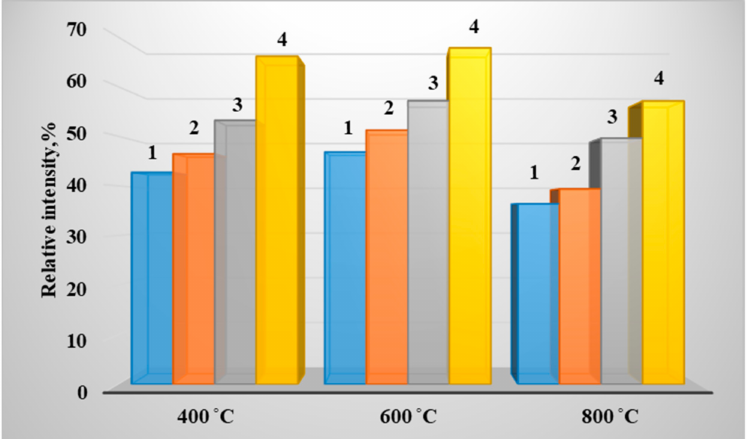
Figure 7. The results of the analysis of the content of aluminum sulfate in ash of brown coal grade 3B, wood and mixtures based on them during pyrolysis of fuel samples weighing up to 15 g in the absence of oxygen in the temperature range from 400 ◦ C to 800 ◦ C:1. Coal 3B_100%; 2. Coal 3B_90%/Wood_10%; 3. Coal 3B_75%/Wood_25%; 4. Coal 3B_50%/Wood_50%